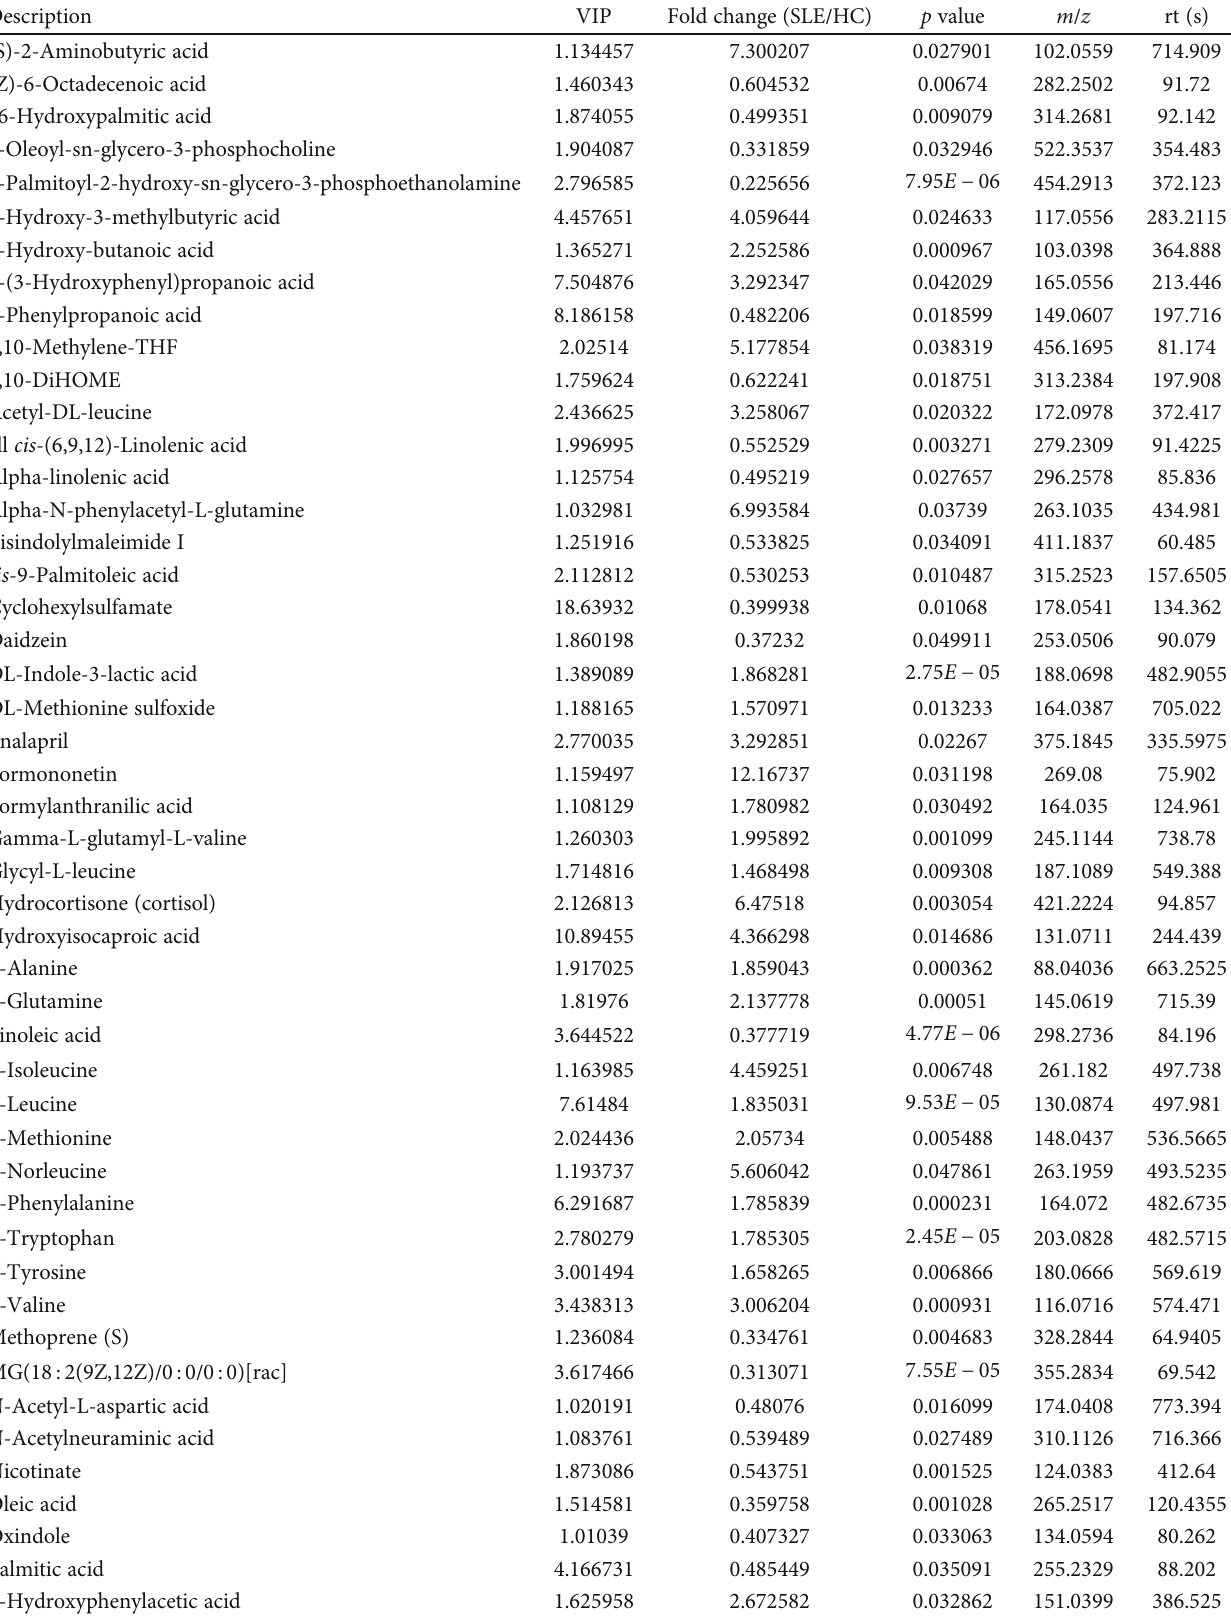
Table 3: Signi fi cantly di ff erent